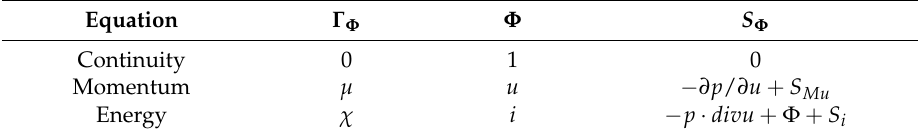
Table 2. Generalized parameter of governing